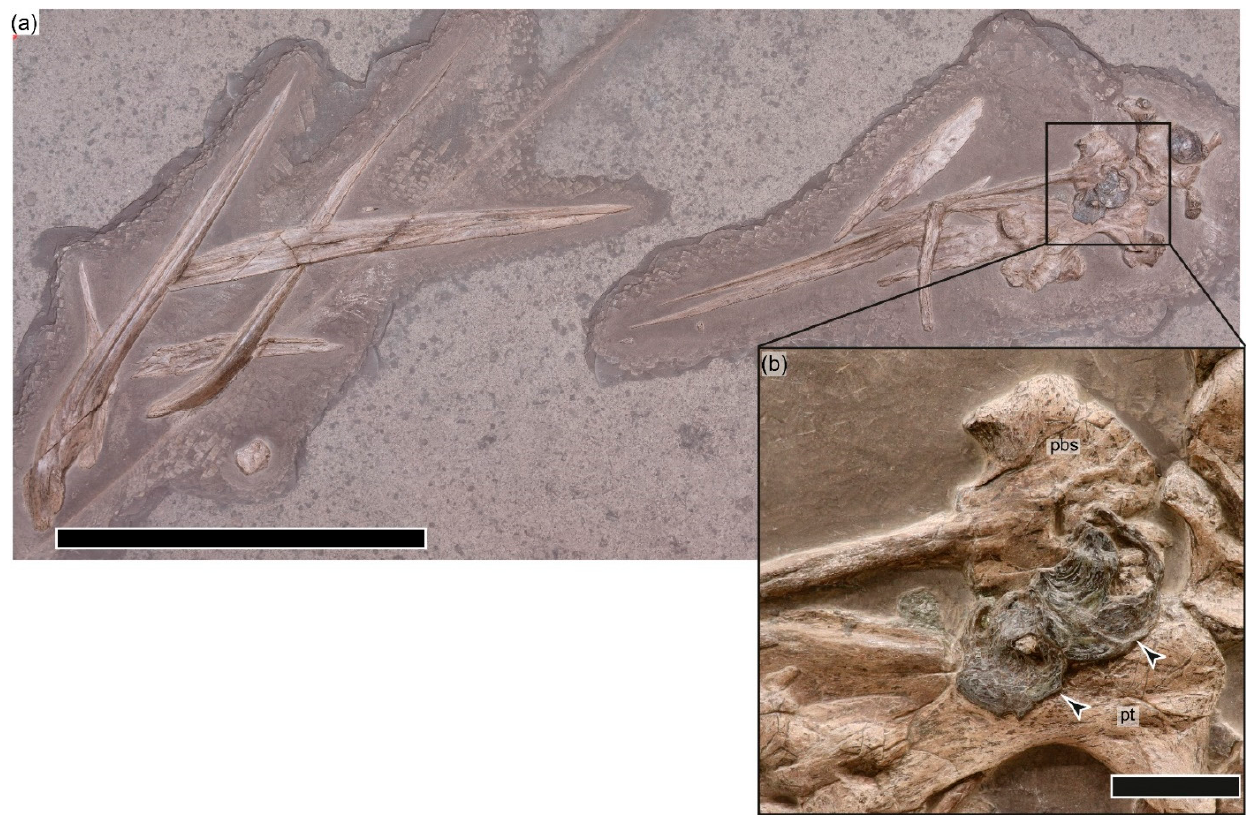
Figure 2 . SMNS 53363, Eurhinosaurus ? ( a ) Photo, copyright M. Wahler/SMNS. ( b ) Close-up of encrusting Liostrea (indicated by arrows). Abbreviations: pbs, parabasisphenoid; pt, pterygoid. Scale bars = 50 cm ( a ), 50 mm ( b ).